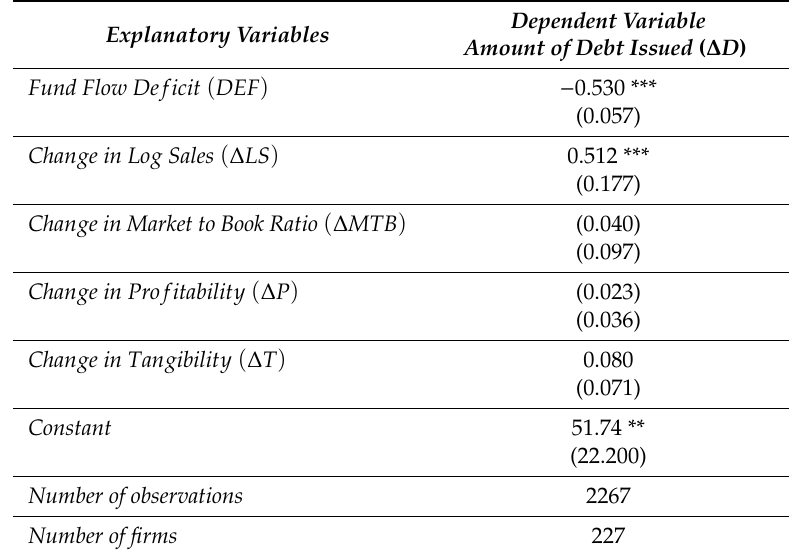
Table 8. Estimation results of the e ff ect of factors on leverage